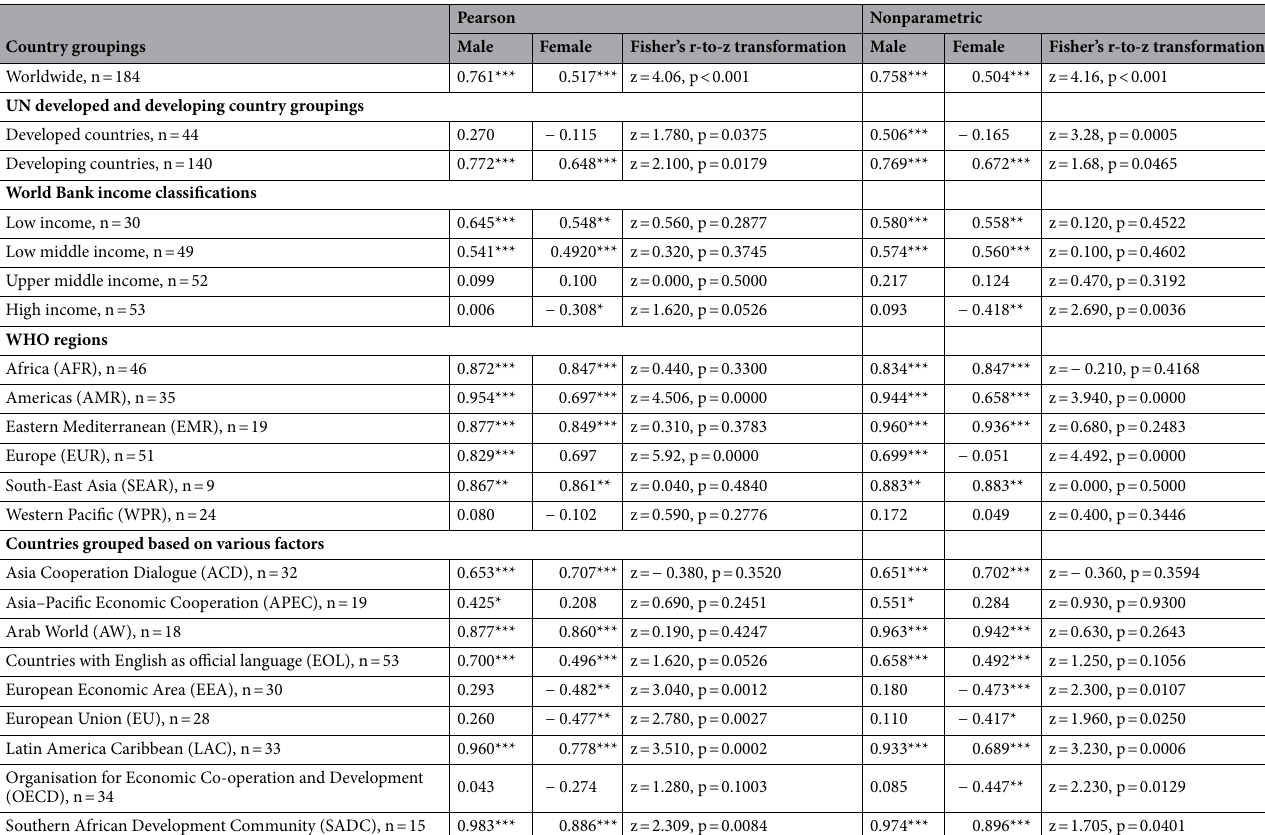
Table 4. Comparisions of bivariate ccorrelation of GDP to sex-specific obesity prevalence rates in different country groupings. *p < 0.05, **p < 0.01; ***p < 0.001; Data sources: Total calories data from the